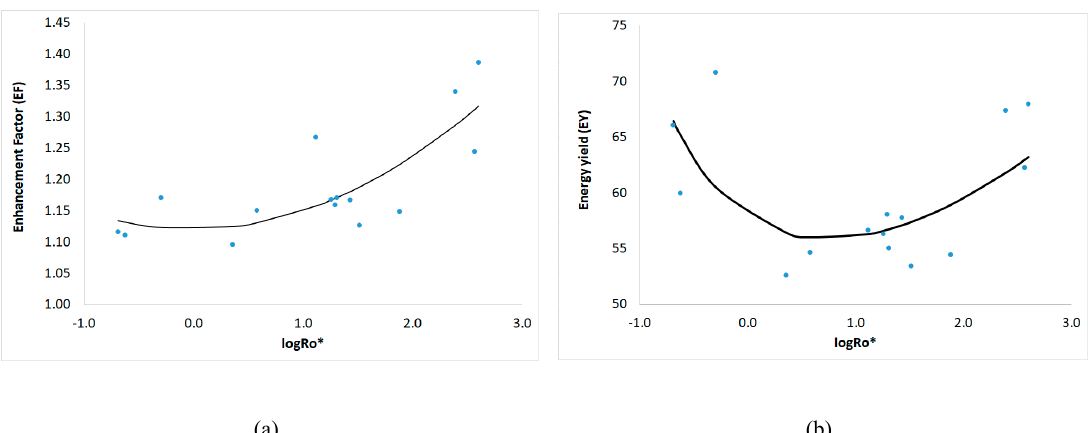
Figure 4. ACWT barley straw ( a ) enhancement factor (EF) and ( b ) energy yield (EY) vs. CSF in